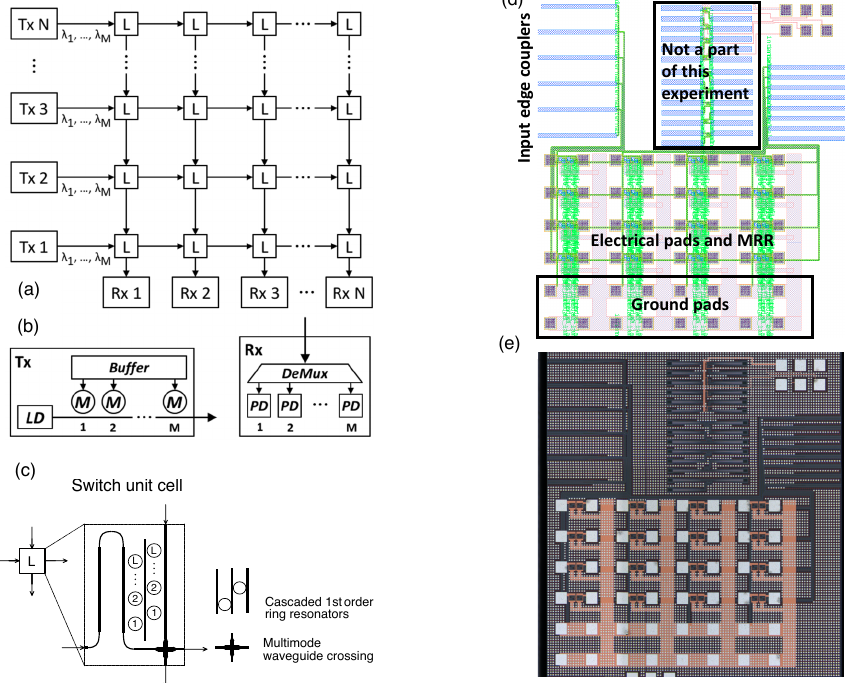
Figure 1. ( a ) N × N switch with L blocks. M wavelengths are input into the switch. ( b ) Tx: Transmitter, M microring modulators each driving one wavelength, Shared buffer so that data to any port can be modulated on any modulator [13]. ( c ) Contents on the L block. L cascaded first order microring resonators and waveguide crossing is used. ( d ) Layout of 4 × 4 switch and ( e ) Die shot of 4 × 4